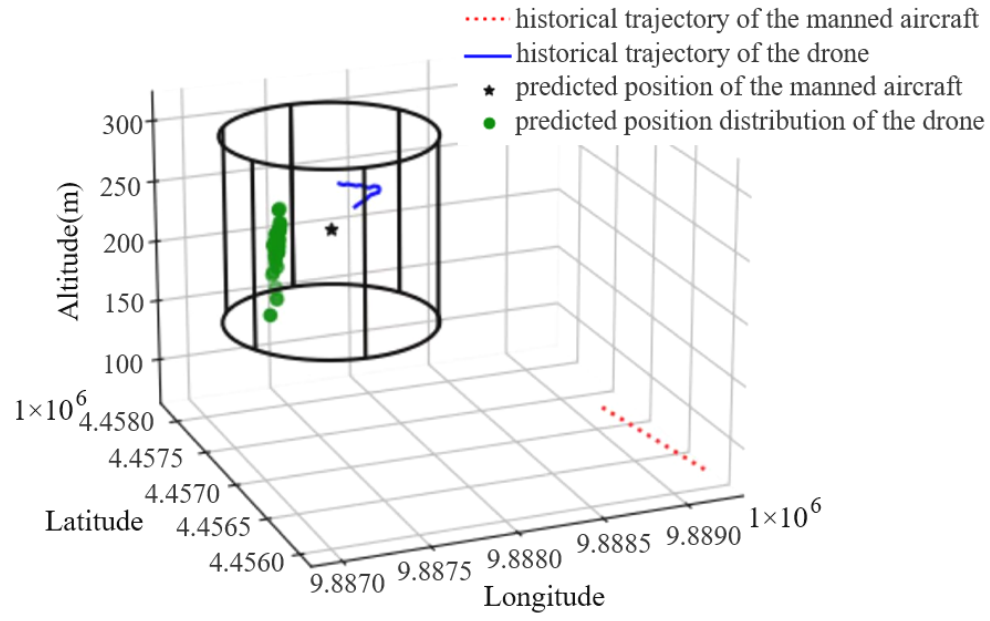
Figure 6. A typical conflict scenario based on the predicted drone and aircraft trajectory.